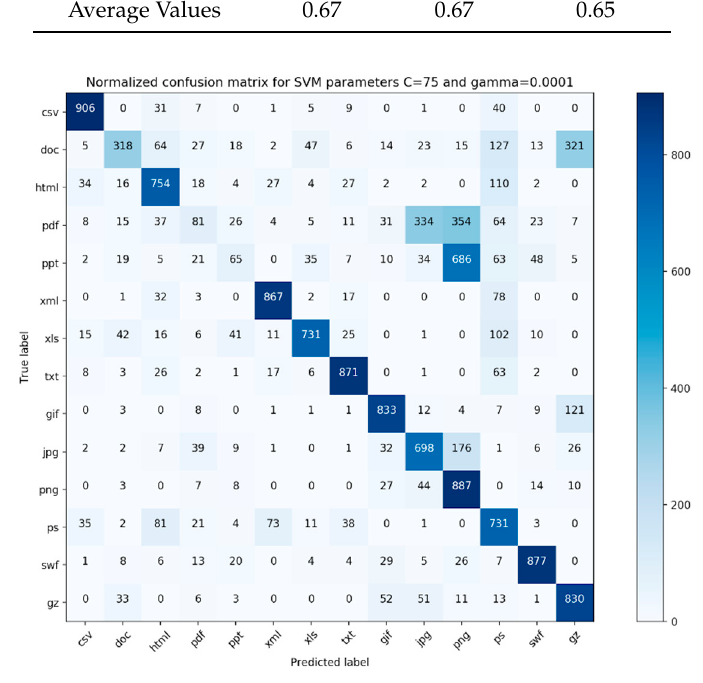
Figure 5. Confusion matrix for the classification of the files using hierarchy 1.